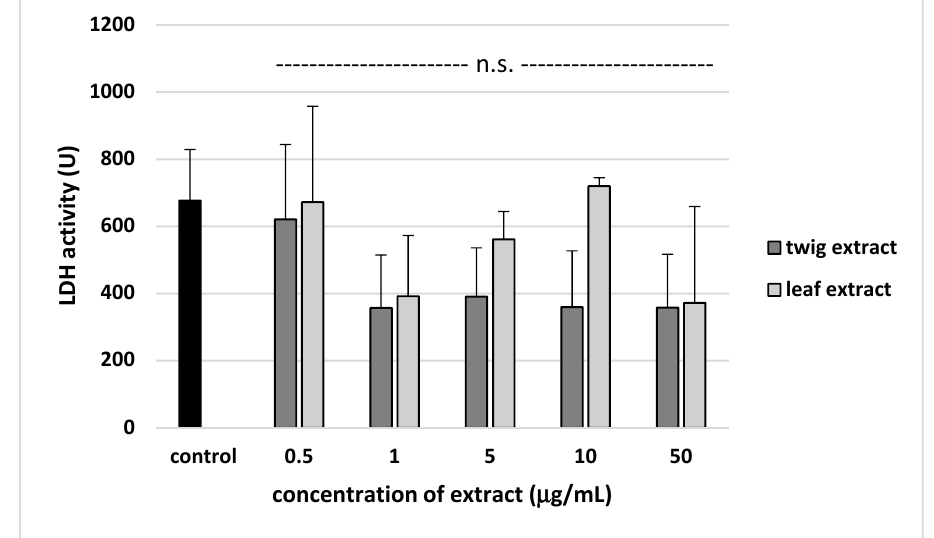
Figure 7. The toxic e ff ects of twig and leaf extract (0.5–50 µ g / mL; 30 min) against human blood platelets. In these experiments, blood platelets not treated with plant extract were used as control samples (positive control). Data represent mean ± SE of 6 healthy volunteers (each experiment performed in triplicate). None of the five di ff erent concentrations of the tested extract (0.5, 1, 5, 10 and 50 µ g / mL) had any statistically significant e ff ect compared to controls ( p > 0.05 (n.s.)).